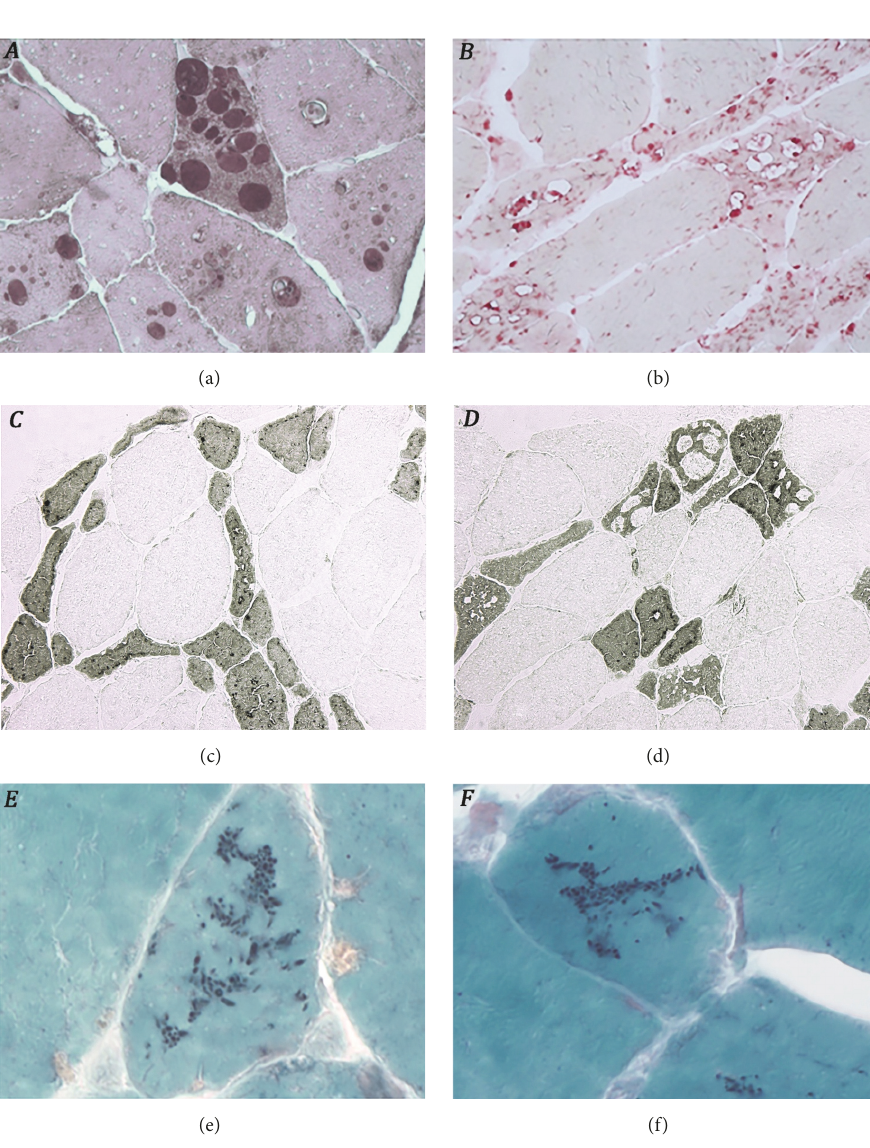
Figure 2: Light microscopy of the left vastus lateralis ((a), resin; (b)-(f),cryostat). (a) Vacuolesfilled with polysaccharide material (PAS, x 40); (b) vacuoles stained positively for acid phosphatase reaction (x 20); (c) ATPase histochemistry at pH 4.3 revealed selective atrophy of type 1 fibers (x 40); (d) vacuoles are present predominantly in type 1 fibers (x 40); (e)-(f) atrophic fibers containing numerous nemaline bodies (Gomori trichrome, x 100).